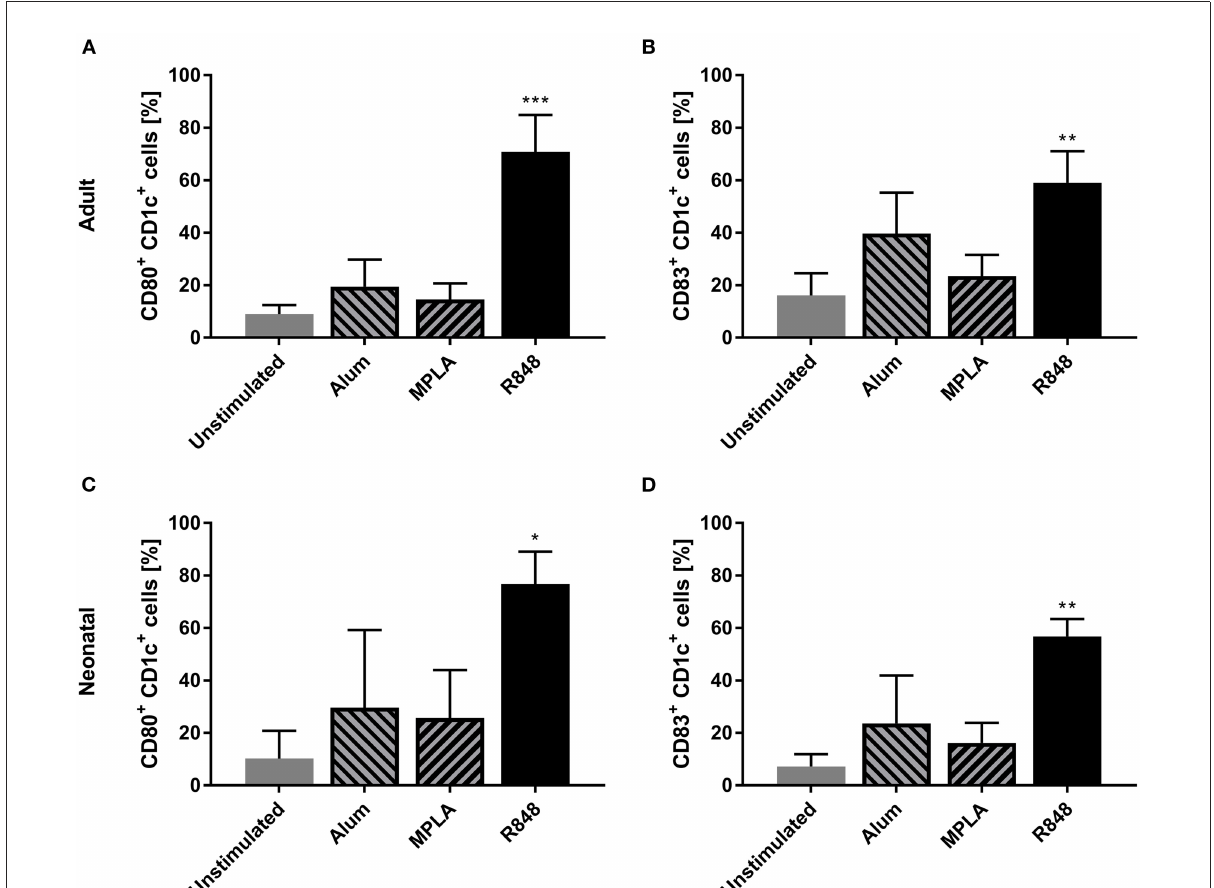
FIGURE1 Effect of different adjuvants on CD1c + cDC2 activation. Adult (A,B) and neonatal (C,D) DCs were incubated with or without alum, MPLA or R848 for 20h. Flow cytometric analysis of CD80 (A,C) and CD83 (B,D) expression by CD1c + DCs after stimulation. Data represent the means ± SD ( n = 3). Significantly greater than unstimulated control: * P < 0.05; ** P < 0.001; *** P < 0.005 (one-way